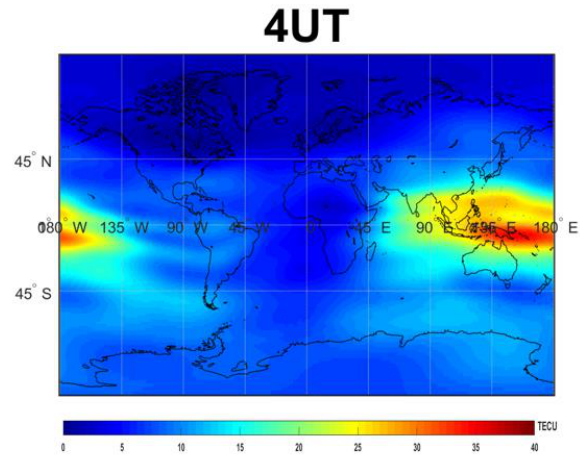
Figure 1 . VTEC-Map at UT = 4 on 1 st January 2018.